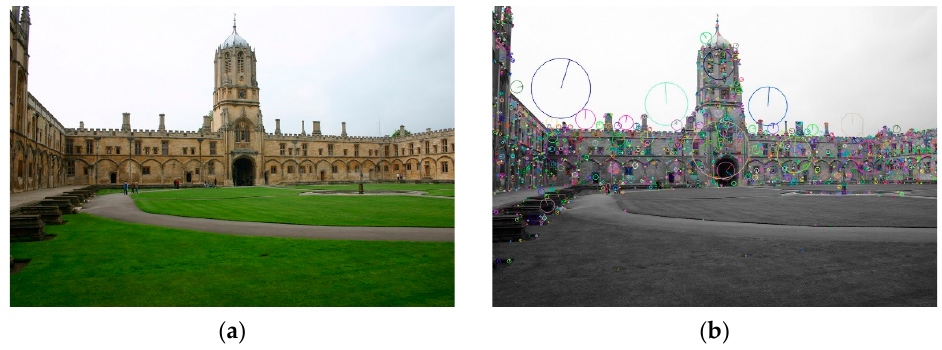
Figure 1. SIFT key point detection. ( a ) is the input image [37]. and ( b ) is the key point description image, which is represented by a small circle at the function position, and the direction of the feature points will be displayed inside the circle. (Source: The Oxford Buildings Dataset).